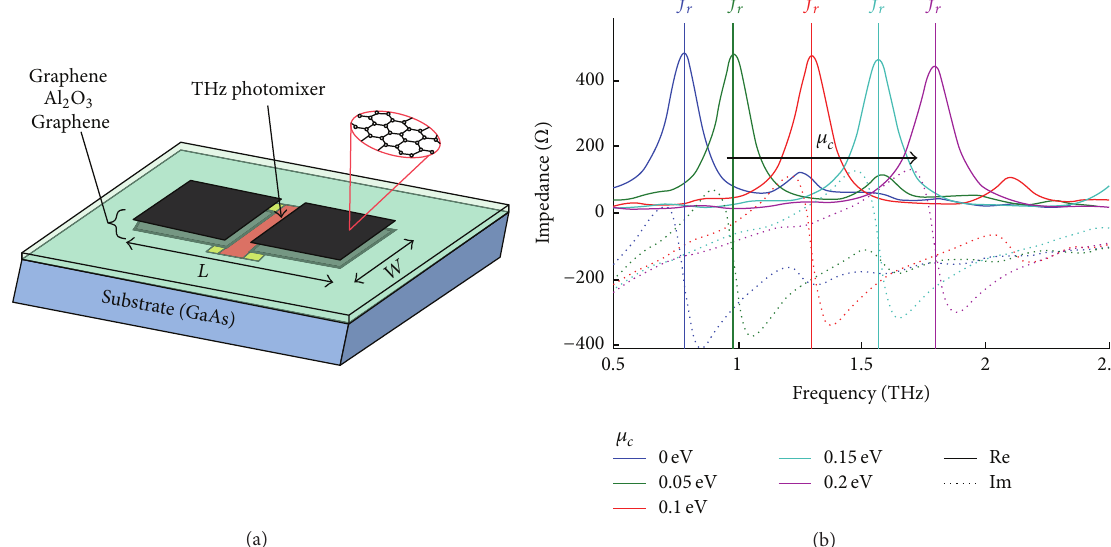
Figure 6: (a) Structure of a reconfigurable graphene antenna. (b) Input impedance of the antenna with respect to chemical potential [29].